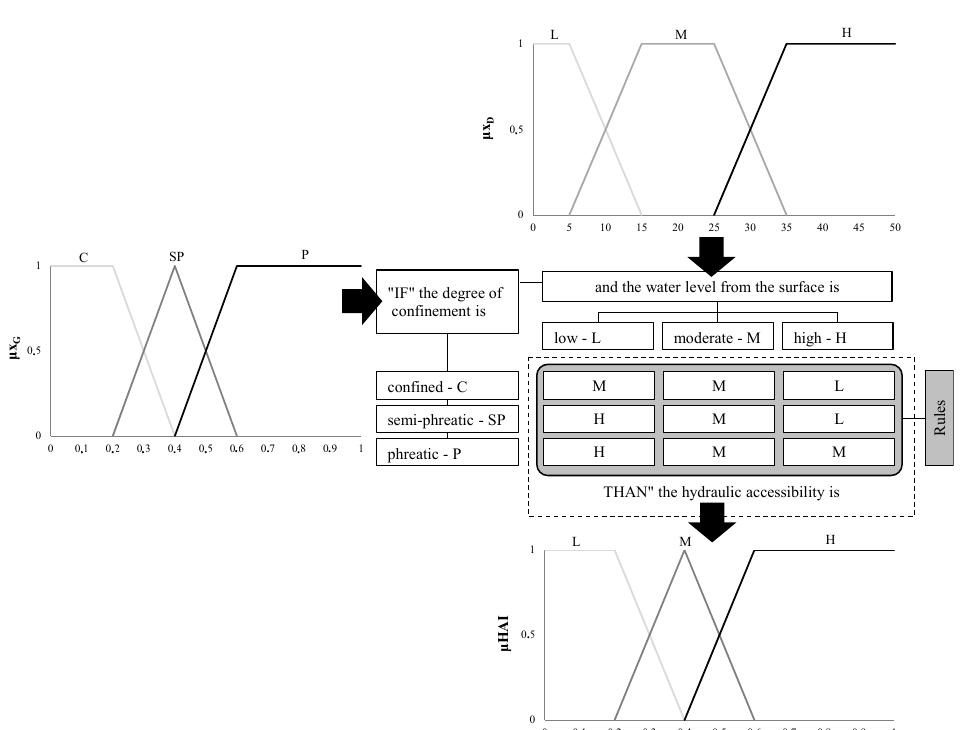
Figure 1. Fuzzy inference system (FIS) for assessing the hydraulic accessibility degree by the hydraulic accessibility index (HAI).